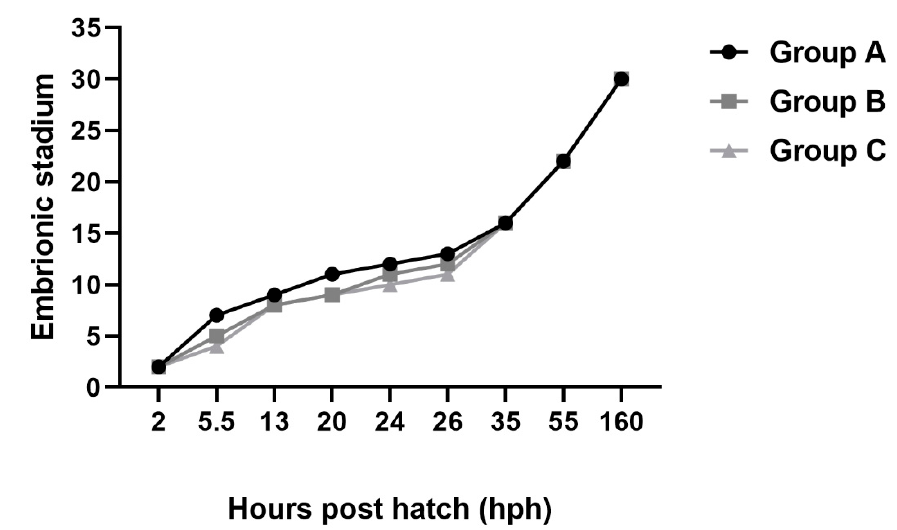
Figure 4. Comparison of embryonic development between hybrid sturgeons in experimental groups.